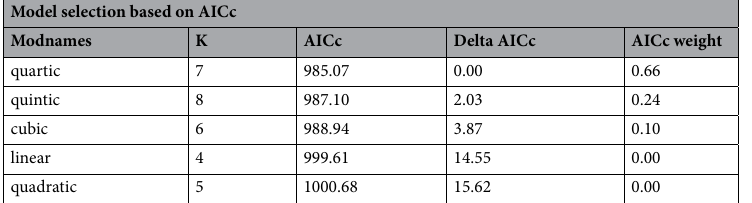
Table 1. Model selection table for d’. The best-fit model is listed first. K, the number of parameters in the mixed model including fixed and random effects. AICc, Akaike Information Criterion corrected for small sample sizes, the smaller the AIC value, the better the model fit. Delta AICc, the difference in AIC score between the best model and the model being compared. AICc weight, which is the proportion of the total amount of predictive power provided by the full set of models contained in the model being